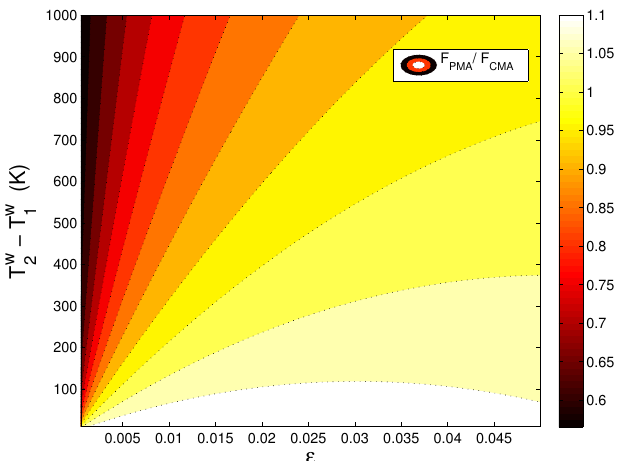
Figure 2. Comparison of compaction force calculated in PMA and CMA under varying thermal and mechanical loading conditions.